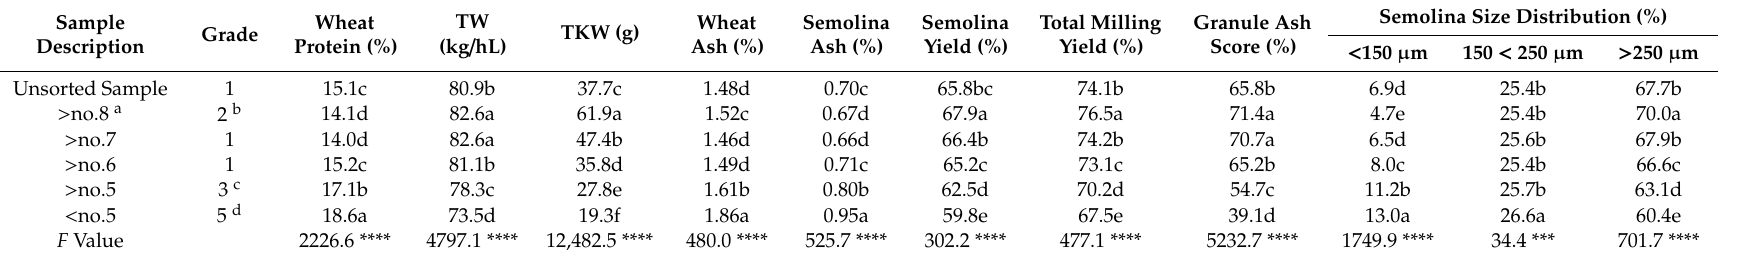
Table 1. Physical and milling properties of durum wheat samples fractionated based on kernel size (set